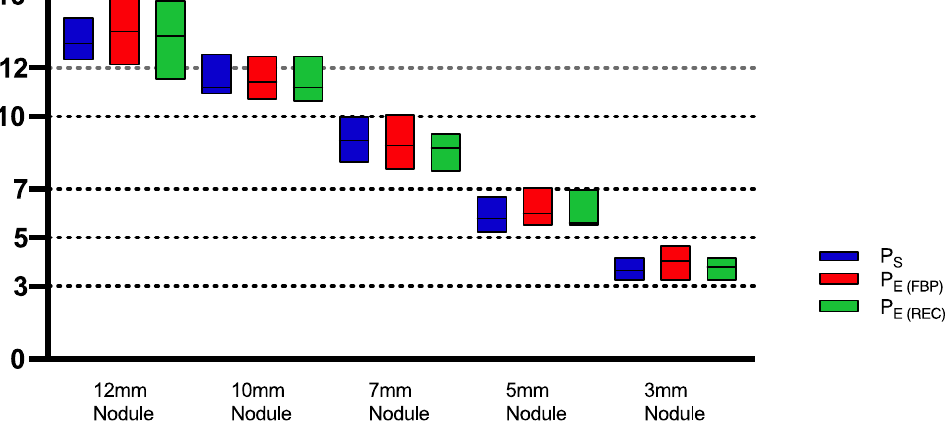
Figure 3. Box-plot diagram of mean ± SD diameter measurements of various nodules sizes (12, 10, 7, 5, 3 mm) among all protocols for all scanners showing nodule size overestimation. P S = Standard Protocol, P E(FBP) = ESTI Protocol with filtered back projection reconstruction algorithm applied, P E(REC) = ESTI Protocol with conventional